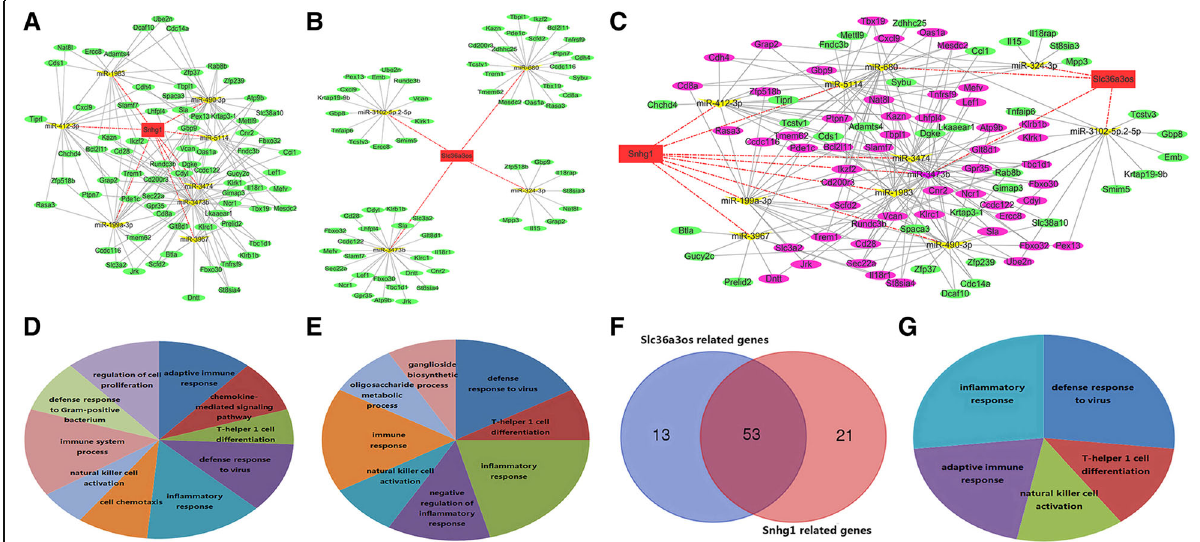
Fig. 5 LncRNAs associated ceRNA networks. Red rectangles represent lncRNAs, green ellipses represent mRNAs, yellow triangles representsmiRNAs, and pink nodes representoverlapped RNAs. a lncRNAsnhg1 associated ceRNA networks. b lncRNASlc36a3os-associatedceRNA networks. c Merged ceRNA networks of lncRNAsnhg1and Slc36a3os. d Enriched GO terms of mRNAs involved in lncRNAsnhg1ceRNA network. e Enriched GO terms of mRNAs involved in lncRNASlc36a3osceRNA network. f Venn diagram of overlapped mRNAs between lncRNAsnhg1and Slc36a3os associated ceRNAs. g Enriched GO terms of overlapped